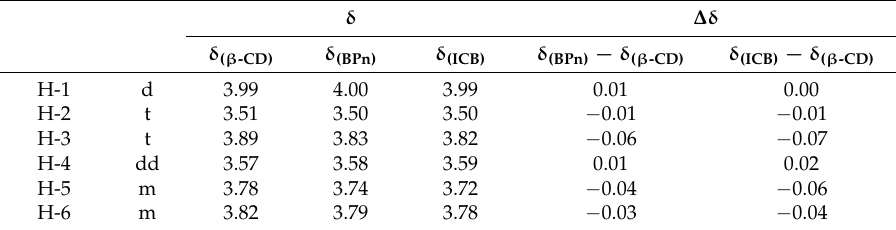
Table 2. 1 H NMR (600 MHz) chemical shift ( δ ) data (in ppm) of pure β -CD, BP n , and ICB.